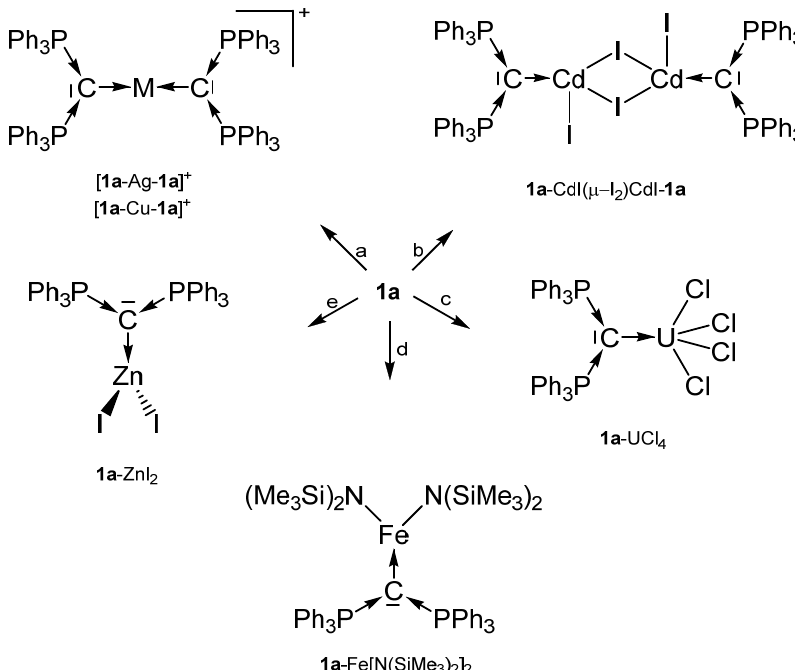
Scheme 1. Selected transition metal compounds with the carbone 1a as two electron donor ligand;